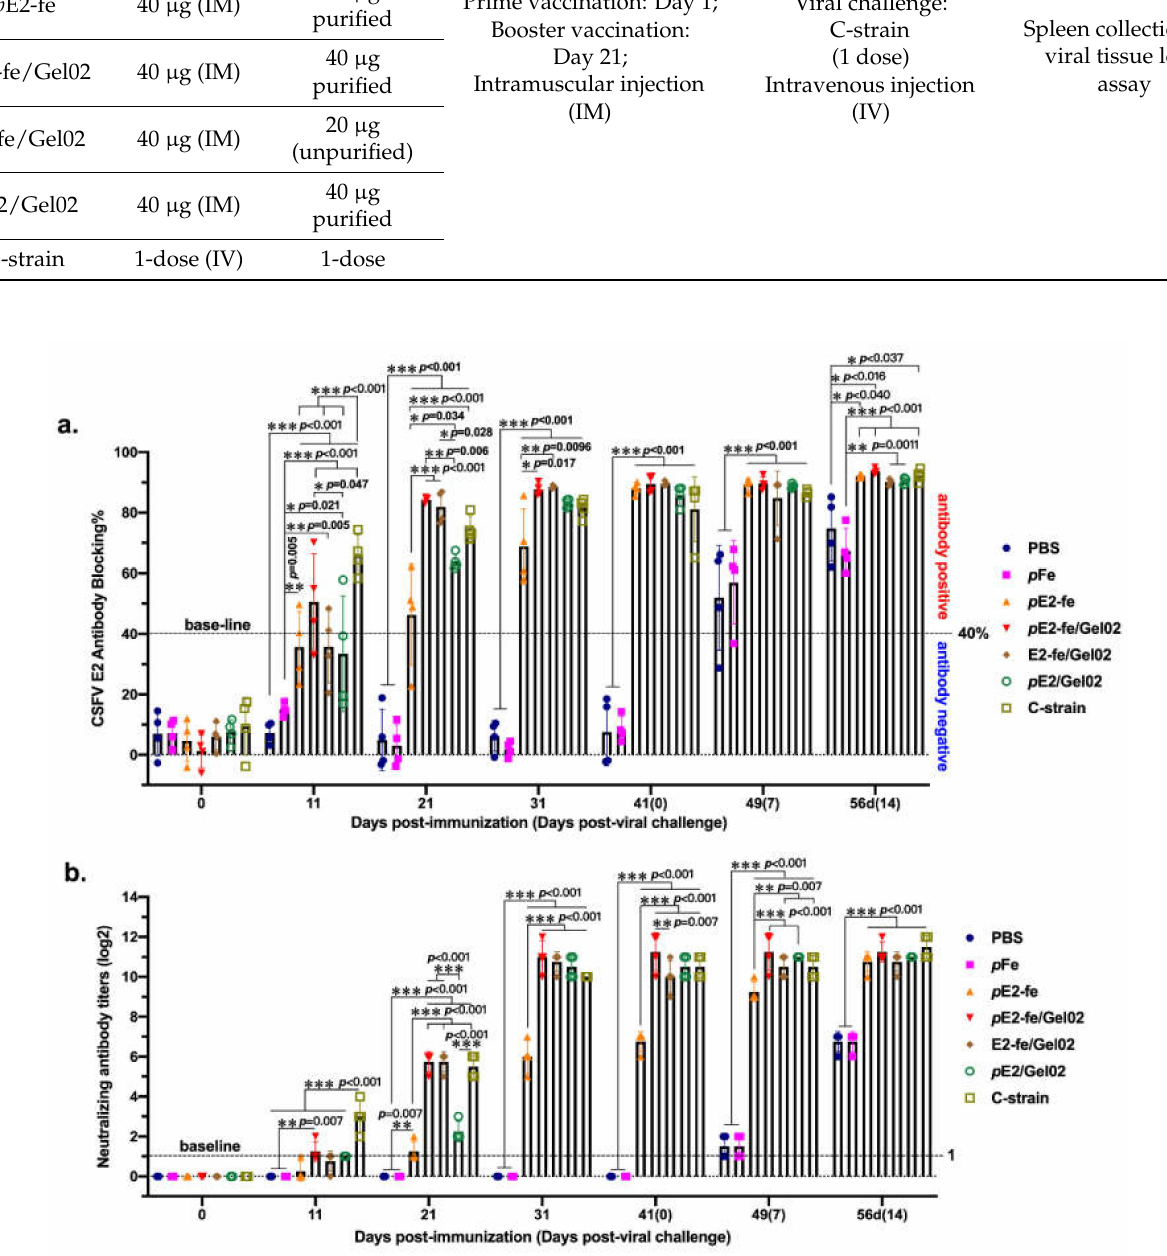
Figure 3. E2-specific antibody blocking analysis and neutralizing antibody titration in vivo. ( a ) CSFV E2-specific antibody blocking rate assay by IDEXX kit. ( b ) CAFV E2 neutralizing antibody titration in pK-15 cells. The data presented